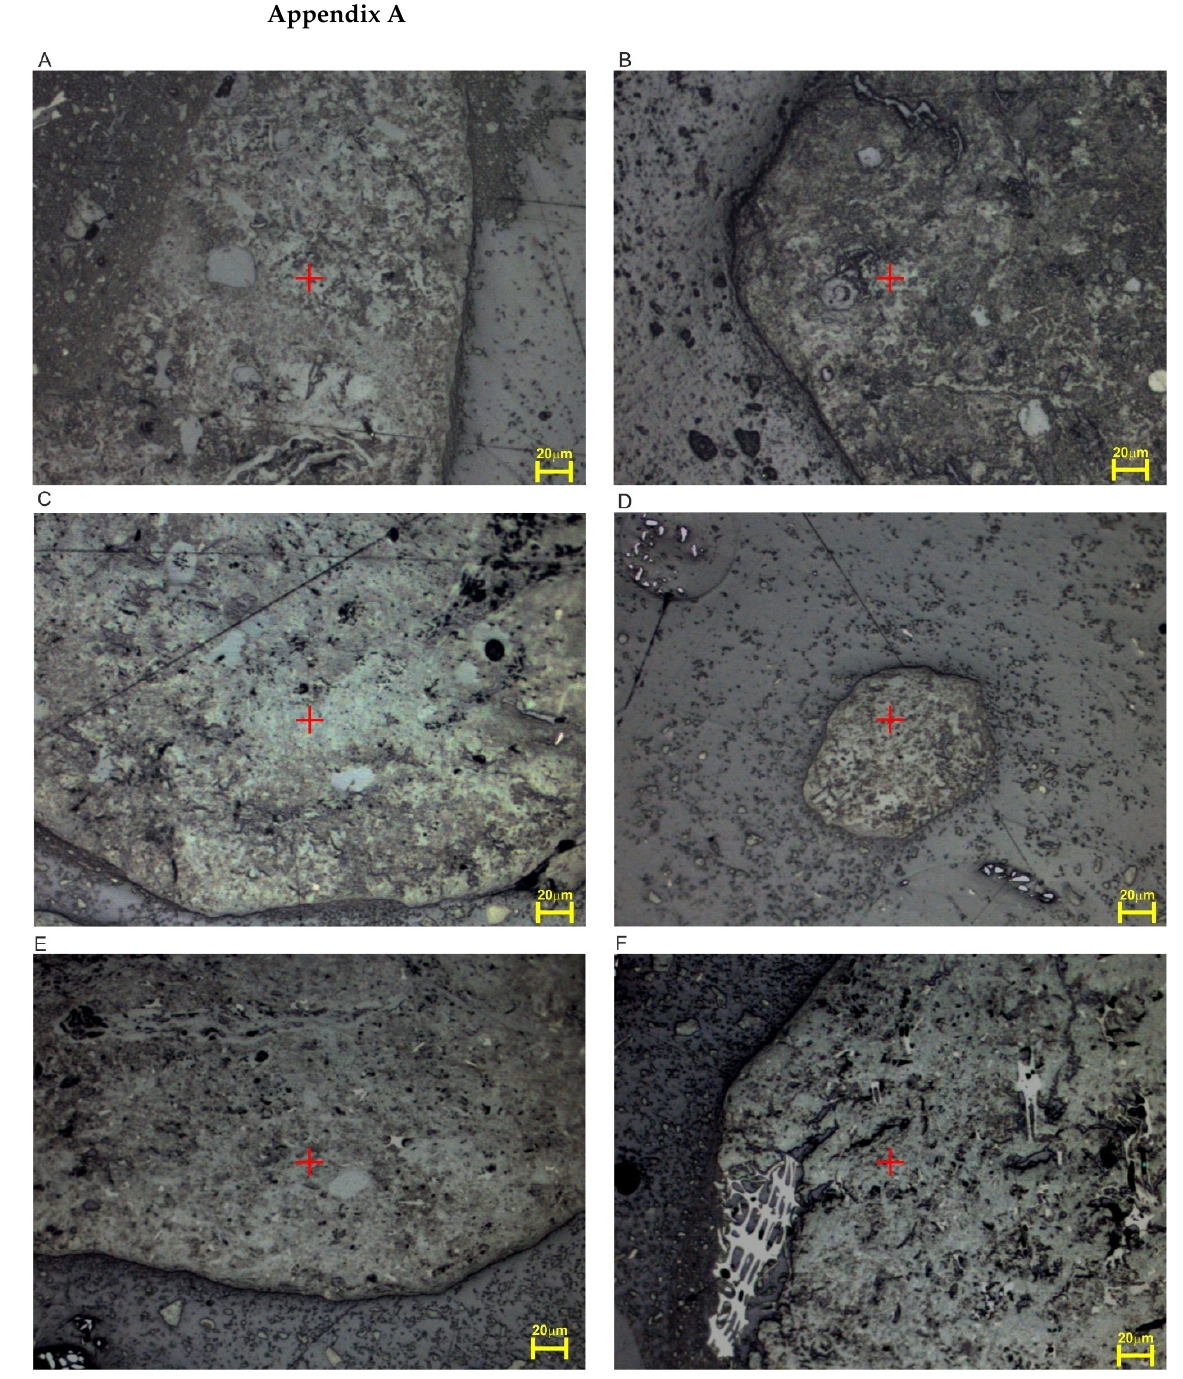
Figure A1. Selected measurement points (+) on attrinite ( A – F ).